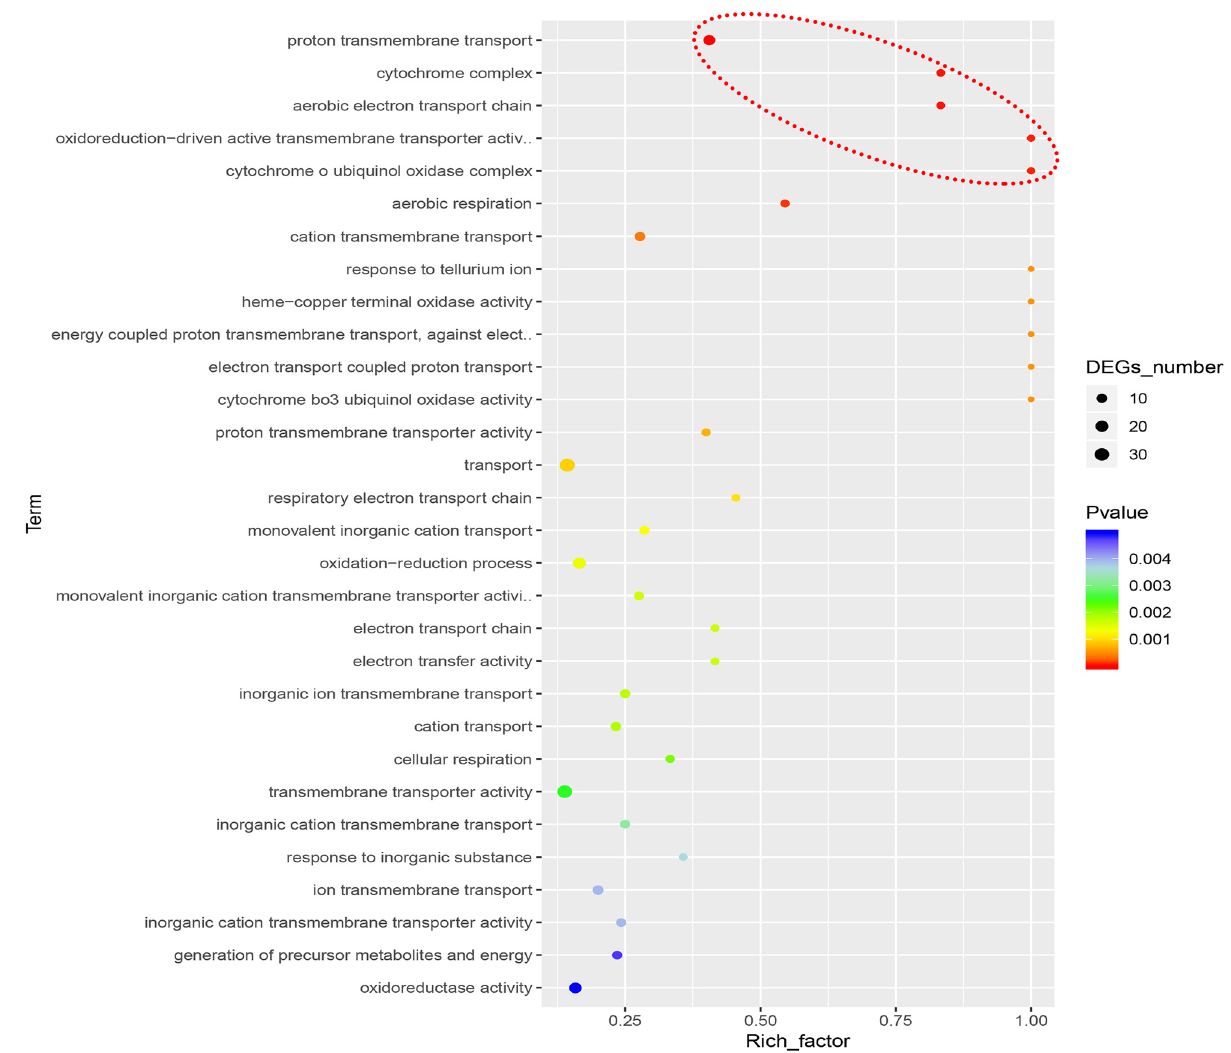
Figure 5: Top GO - enriched pathways. A large rich factor indicates a high degree of